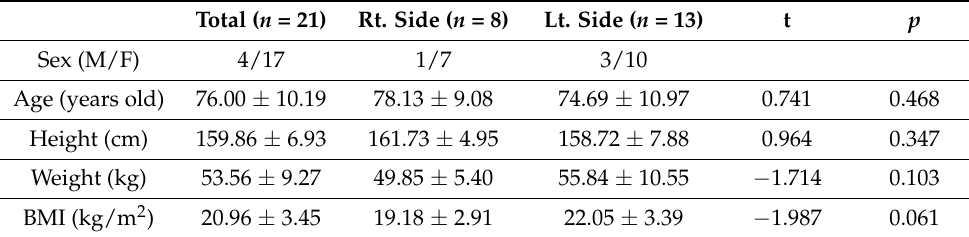
Table 4. General characteristics of study